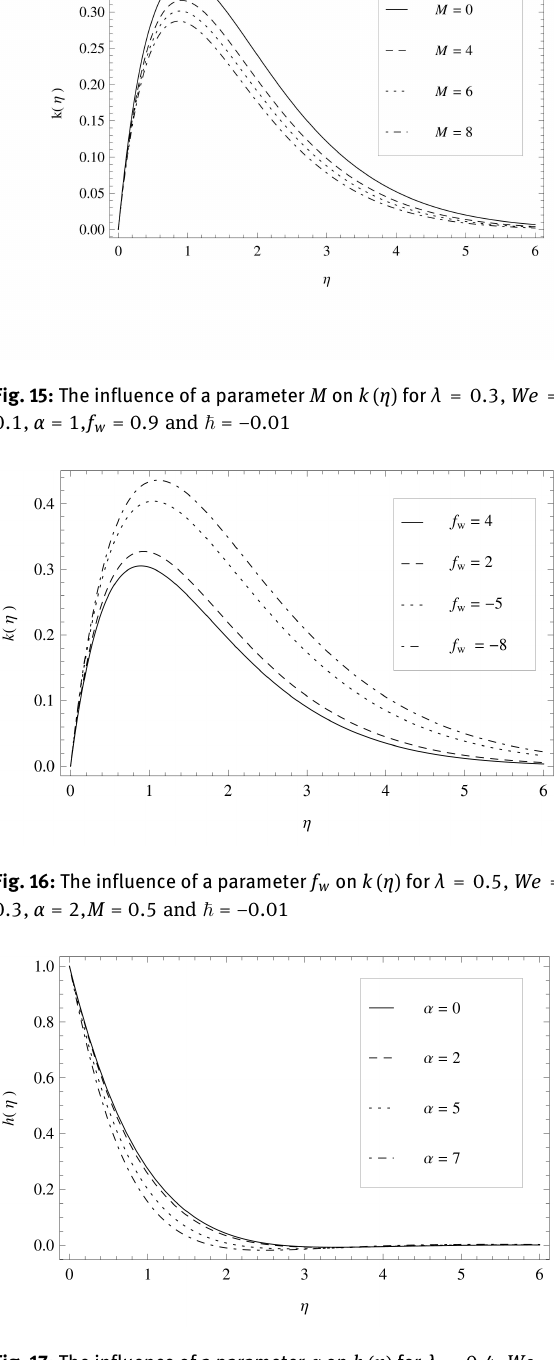
Fig. 17: The influence of a parameter α on h ( η ) for λ = 0.4, We = 0.2, M = 0.3, f = 0.09 and (cid:126) = w